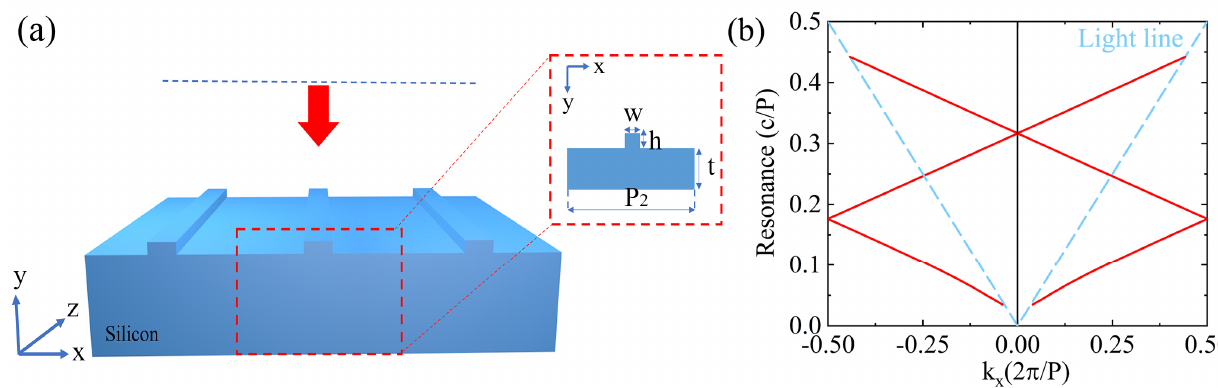
Figure 1. ( a ) Schematic of a regular ridge grating on a slab waveguide in air, with inset presenting an enlargement of a single periodic cell. ( b ) Dispersion diagram calculated for P 2 = 99 μ m and ridge width W of 10 μ m. The dashed blue line is for light in free space. The upper two branches above the light line are related to the GMR, which happens around the Γ point corresponding to the second stop band of the grating.